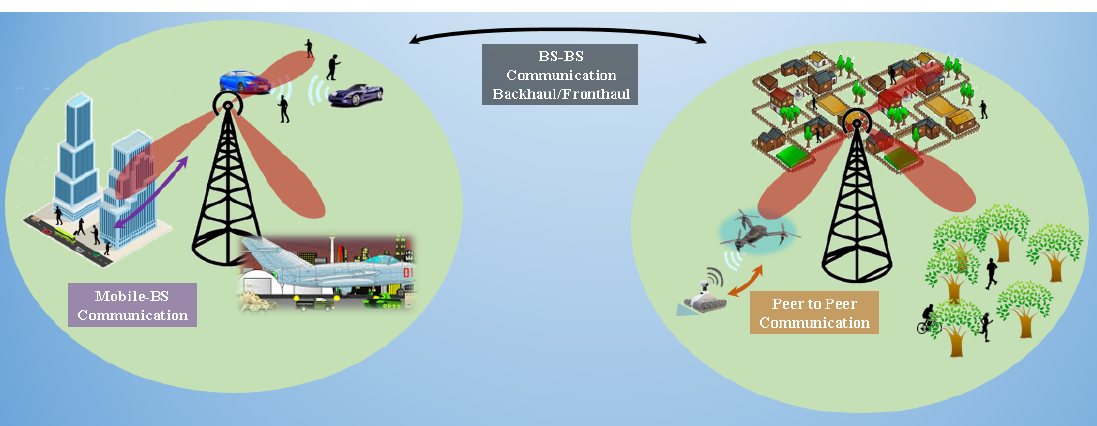
Figure 1. Illustration of different 5G communication